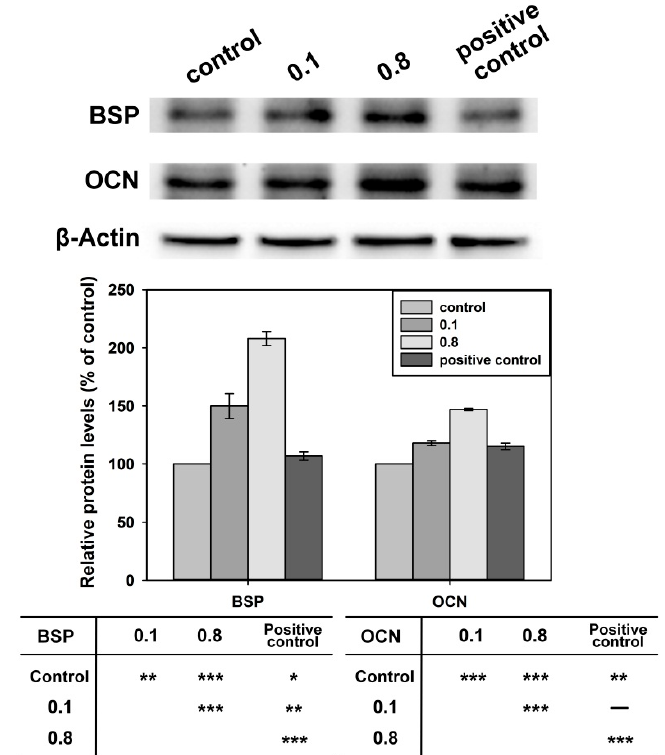
Figure 9. Western blot assays of the bone sialoprotein (BSP), osteocalcin (OCN) and β -Actin expression of MC3T3-E1 cells when combined with 0.1 and 0.8 mg/mL Rod-CC NPs, and the osteoinduced medium without nanoparticles was used as positive control. Table shows pair-wise comparison results of each group (* p < 0.05, ** p < 0.01, *** p < 0.001; n = 4).